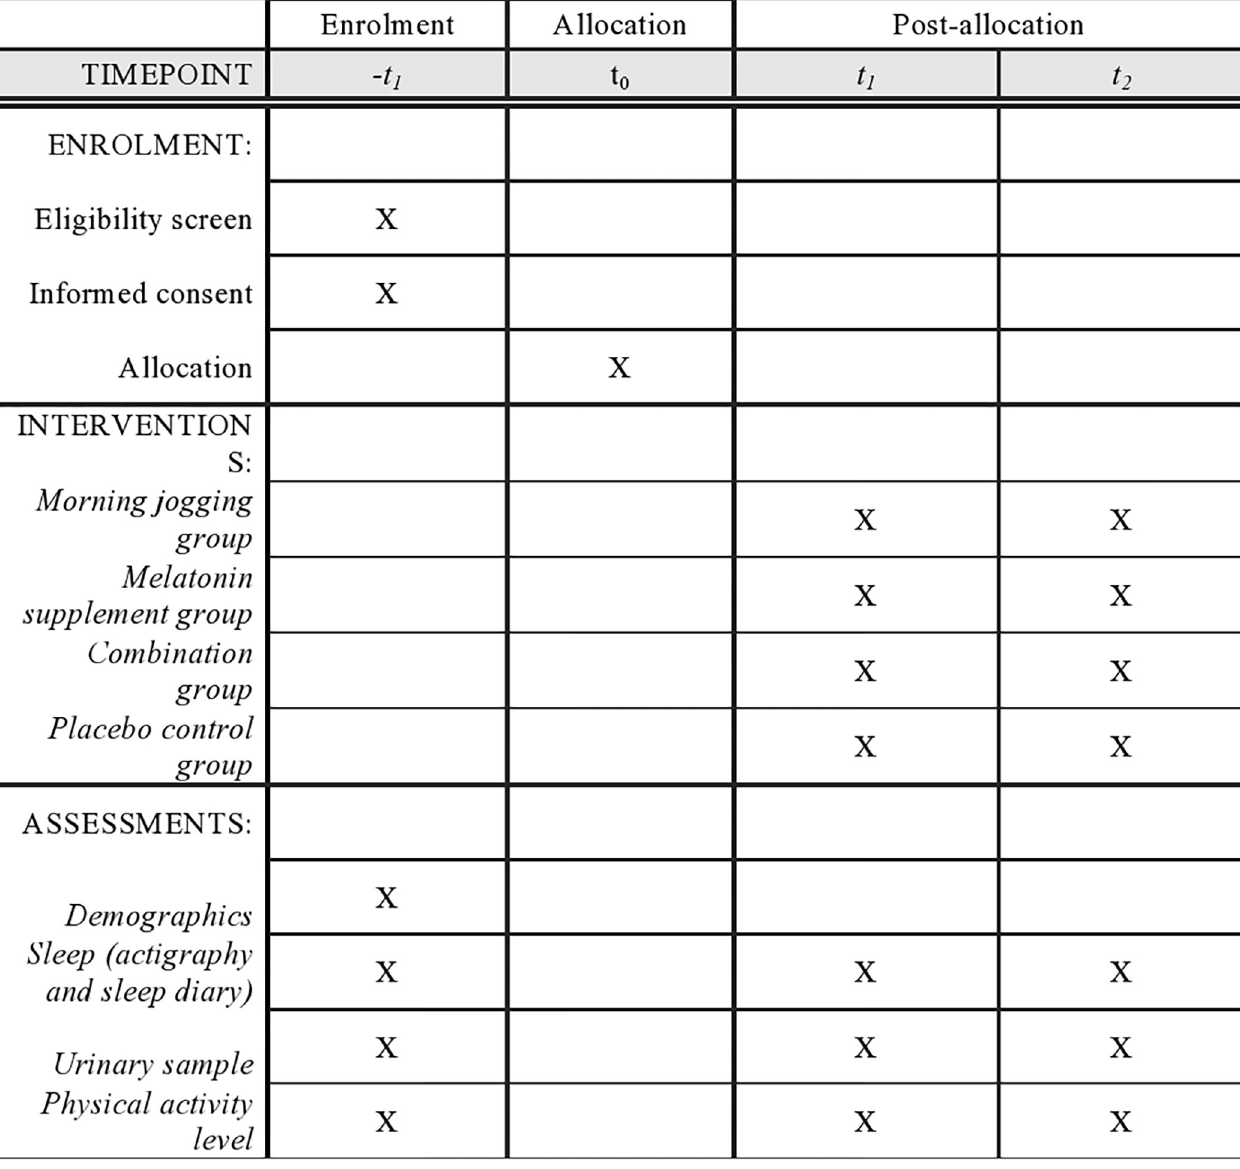
Fig 1. SPIRIT schedule of enrolment, interventions, and assessments of the study.